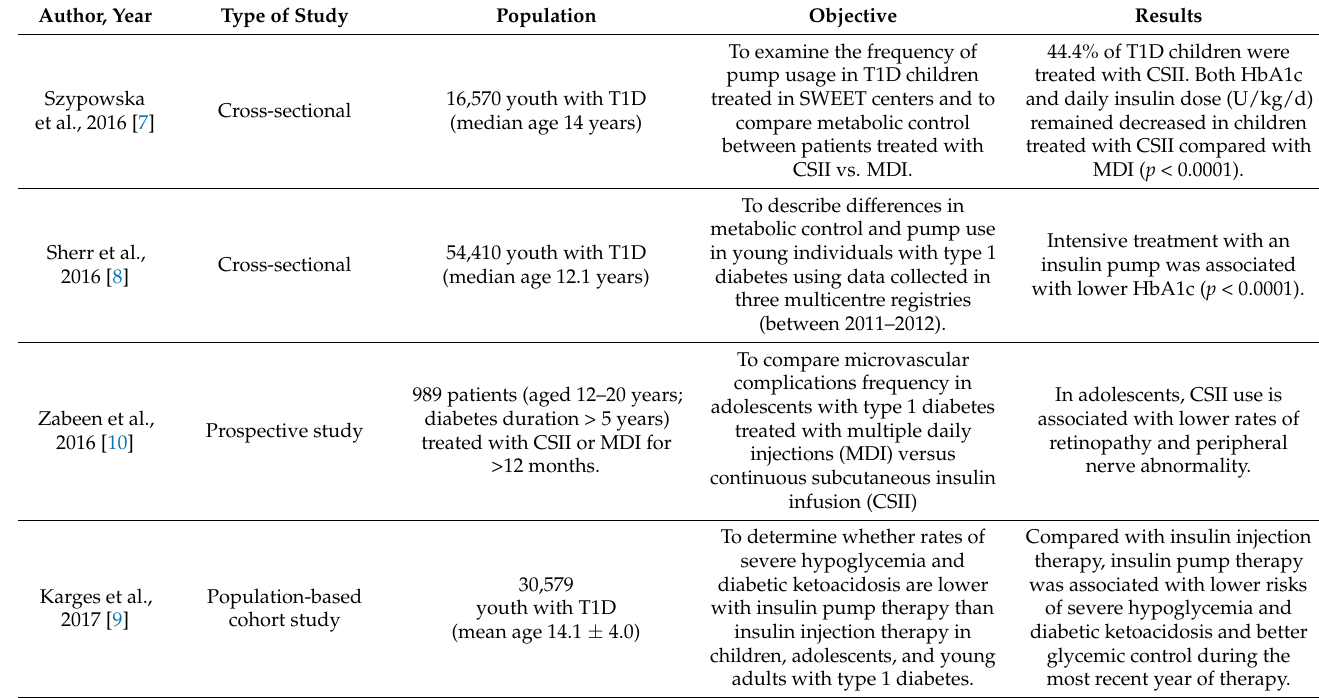
Table 1. Studies investigating efficiency of CSII versus MDI.